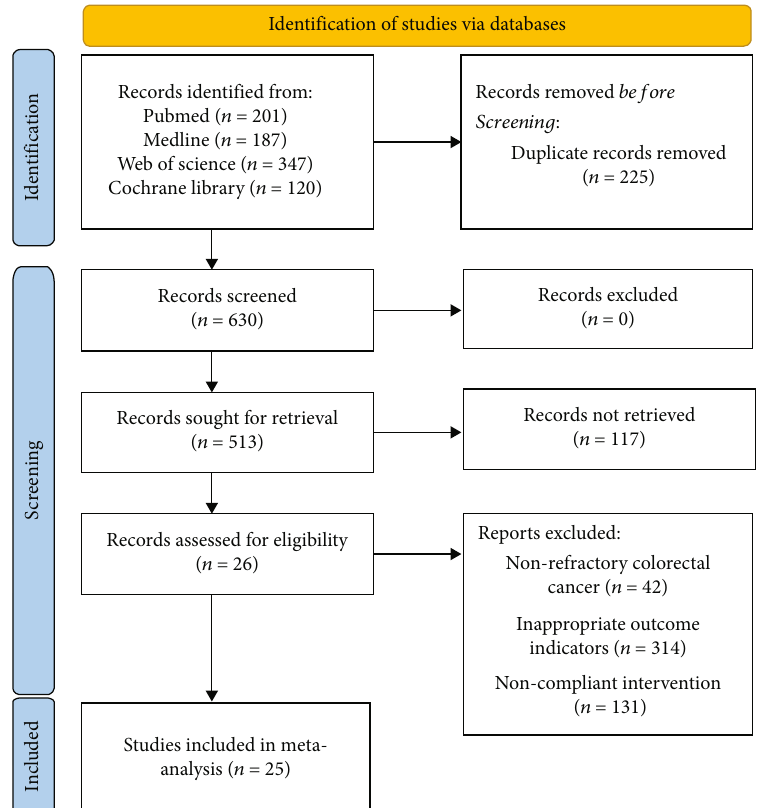
Figure 1: Flow diagram showing the search and screening